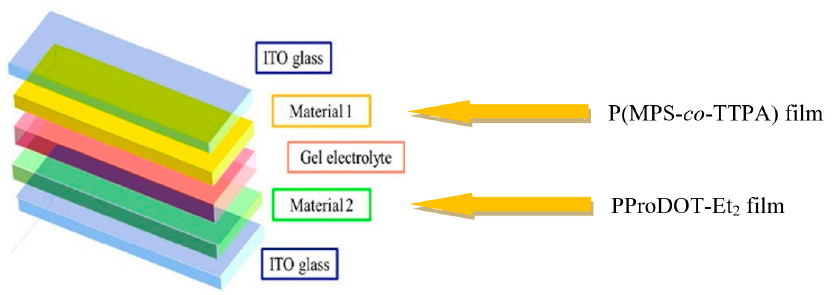
Figure 1. Schemes of a P(MPS- co -TTPA)/PProDOT-Et 2 electrochromic device.